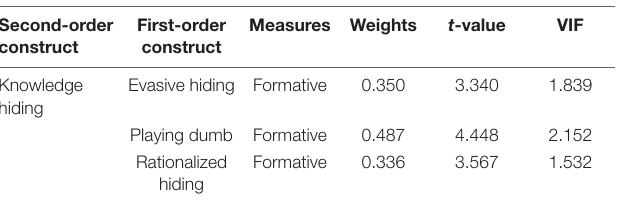
TABLE 3 | Weights of the first-order construct on the designated second-order constructs.